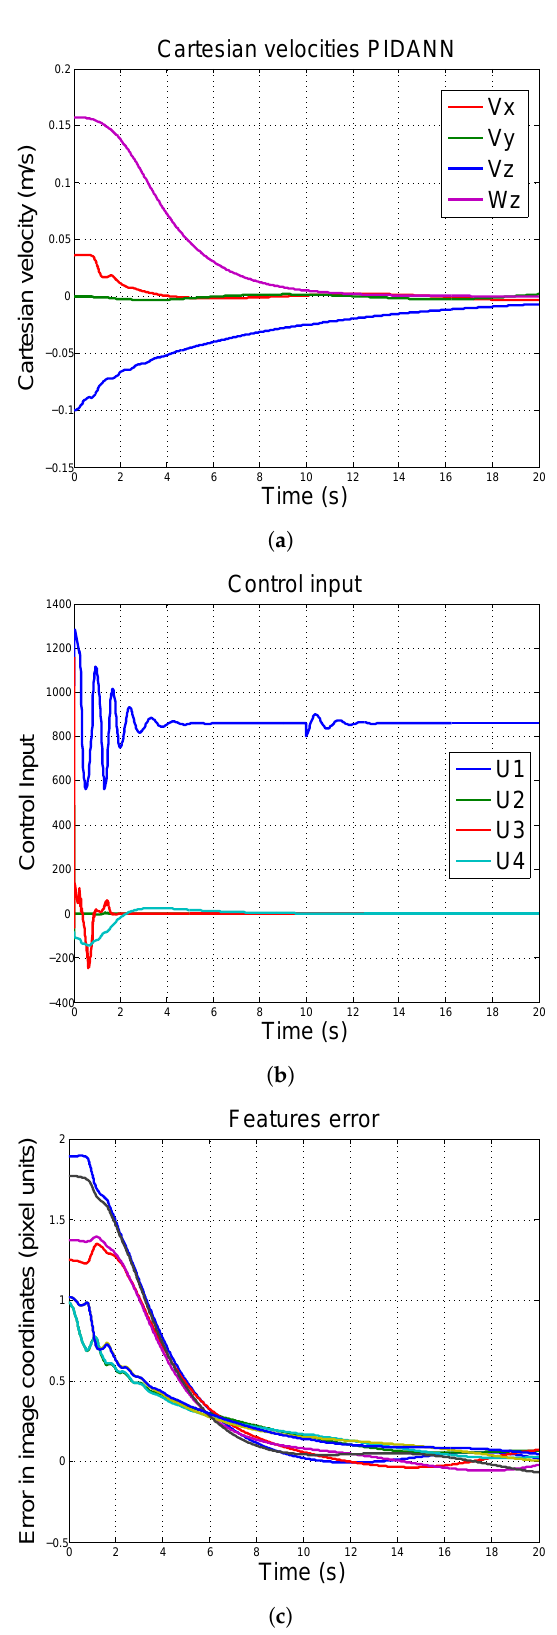
Figure 8. Simulation using conventional PID-ANN. At 10 s, the mass of the system is incremented 50% and λ = 0.3. The system remains at desired position. ( a ) Cartesian velocities; ( b ) control input; ( c ) features